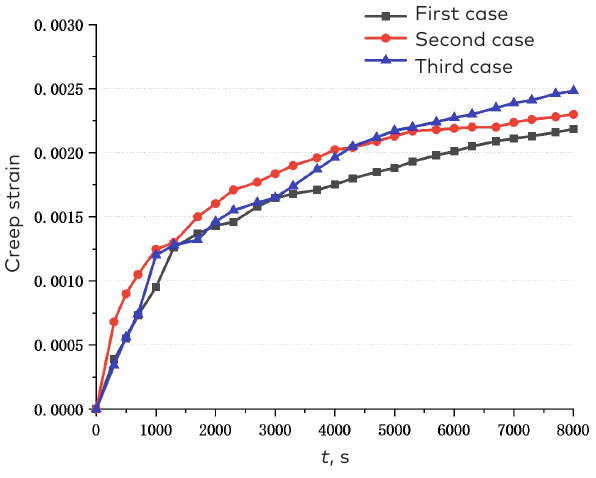
Figure 11. Effect of random distribution of aggregate on the creep